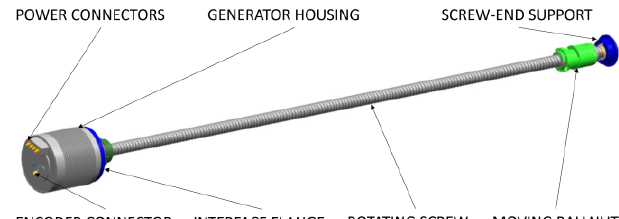
Fig. 3. EMU design.